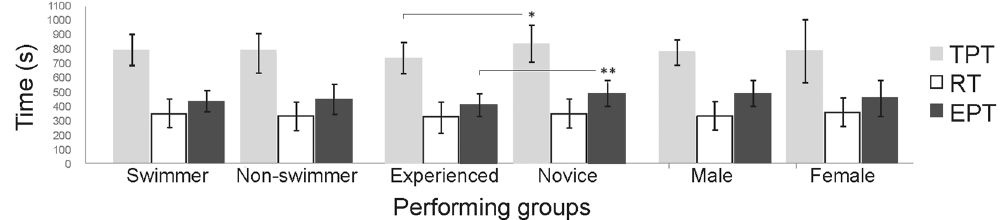
Figure 2. Mean TPT, RT and EPT in different performing groups (TPT: total playing time; RT: rest time; EPT: effective playing time; * and ** : differences between TPT and